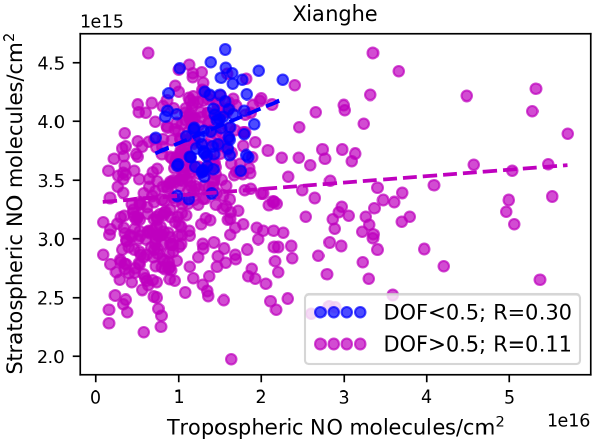
Figure 10. Scatterplots at Xianghe between the tropospheric NO partial columns and stratospheric NO partial columns with the DOF less than 0.5 (blue) and greater than 0.5 (magenta) in the tropo- sphere. R is the correlation coefficient. Only the results at Xianghe are presented here as there is no retrieval with a DOF larger than 0.5 in the troposphere at